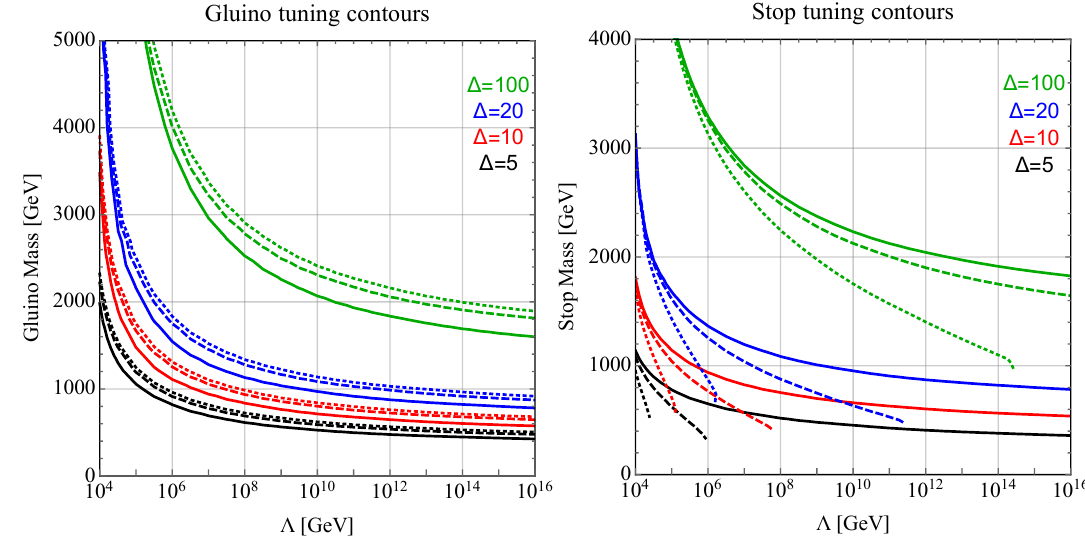
Figure 8 . Tuning contours of IR gluino (left) and stop mass (right) for (cid:1) = 5 (black), 10 (red), 20 (blue) and 100 (green) as a function of messenger scale (cid:3). In both plots, the 1st and 2nd generation squark masses are set equal to the 3rd generation mass (solid lines), at 5 TeV (dashed lines), and 10 TeV (dotted